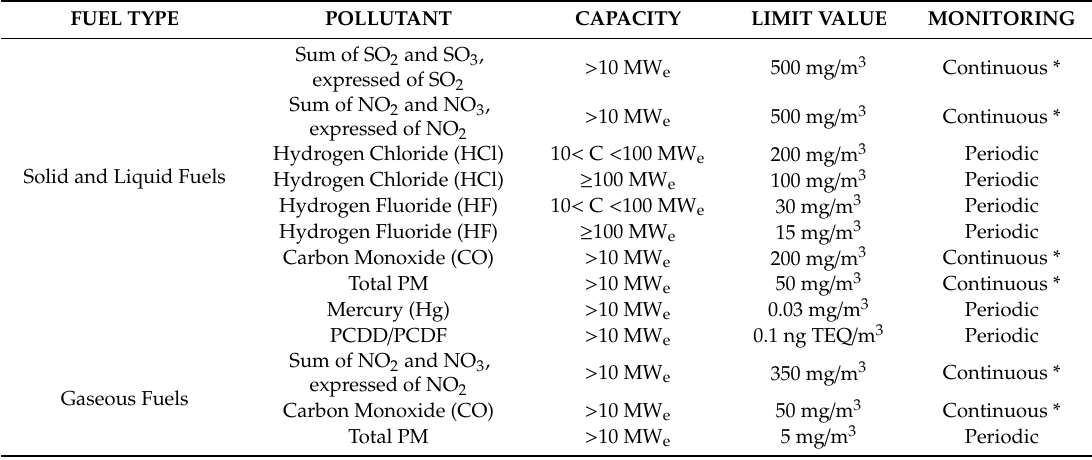
Table A1. Limit values and technical standards for boiler [34].